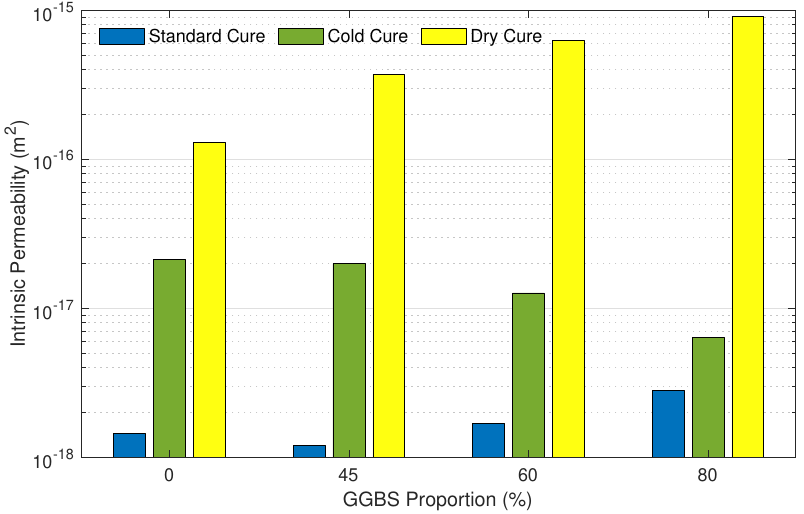
Figure 2. Intrinsic permeability of mortar samples in function of their GGBS proportion and curing